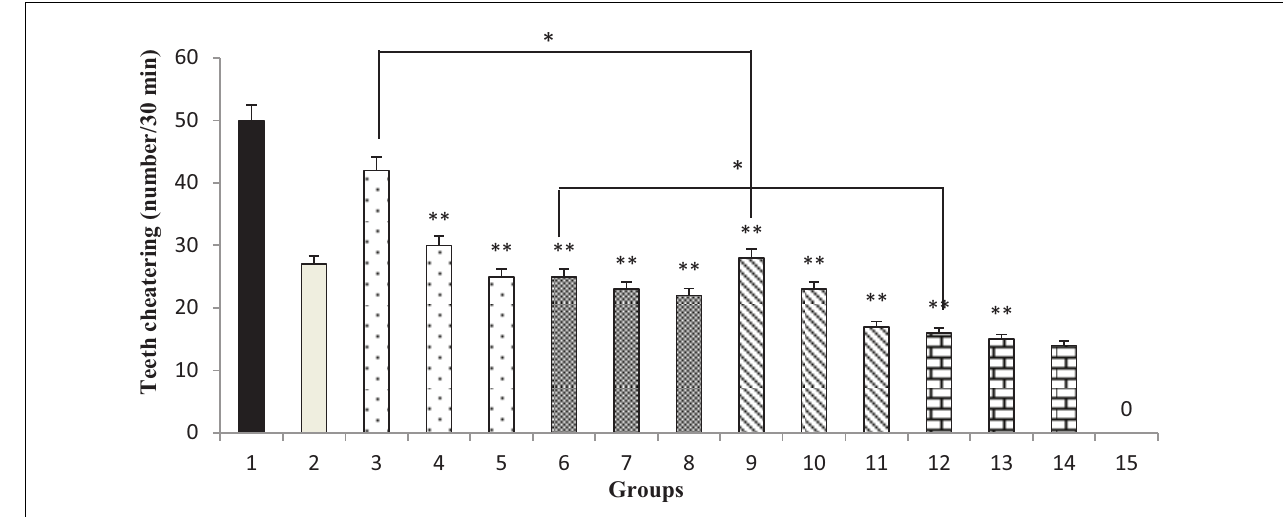
FIGURE 11 | The frequency (number of teeth chattering/30 min) of teeth chattering in rats. Group 1; morphine-dependent rats (control). Group 2; morphine-dependent rats and coadministration of clonidine hydrochloride (0.2 mg/kg i.p.) (positive control). Groups 3, 4, and 5; morphine-dependent rats and the coadministration of 100, 200, and 300 mg/kg T. spicata extract, respectively. Groups 6, 7, and 8; morphine-dependent rats and coadministration of 30, 60, and 90 mg/kg thymol, respectively. Groups 9, 10, and 11; morphine-dependent rats and coadministration of 100, 200, and 300 mg/kg extract nanopolymer, respectively. Groups 12, 13, and 14; morphine-dependent rats and coadministration of 30, 60, and 90 mg/kg thymol nanopolymer, respectively. Group 15; non-dependent rats (saline). Data are expressed as mean ± SEM. ∗ P < 0.01 vs. control, ∗∗ P < 0.001 vs.